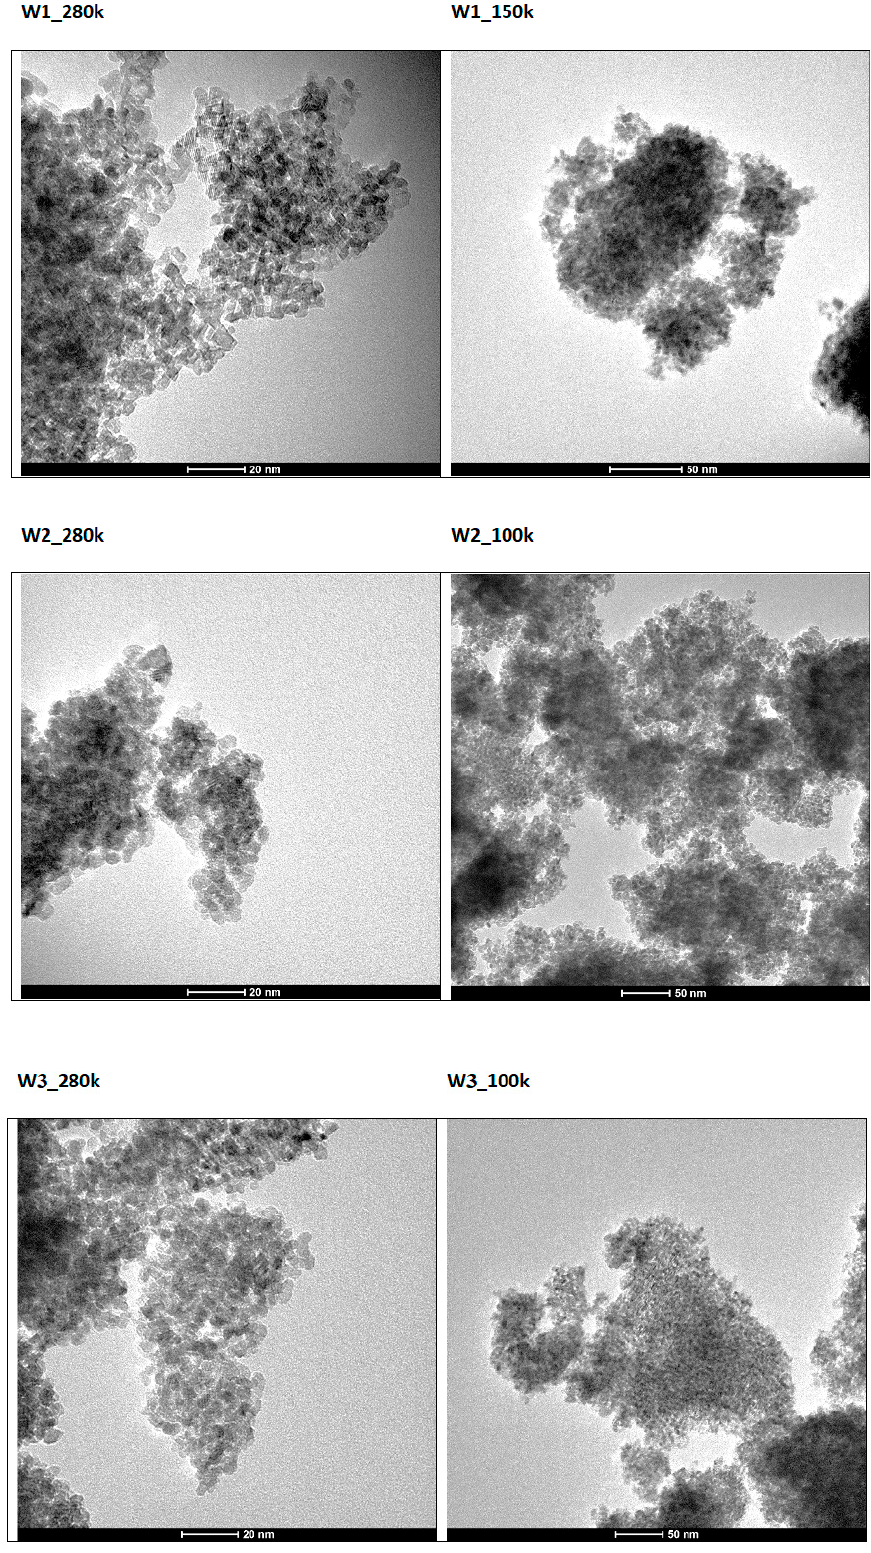
Figure 3. Transmission electron microscopy (TEM) images of powder catalysts: W1, W2 and W3.